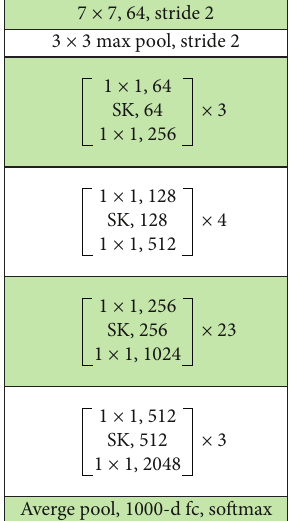
Figure 4: Network structure of